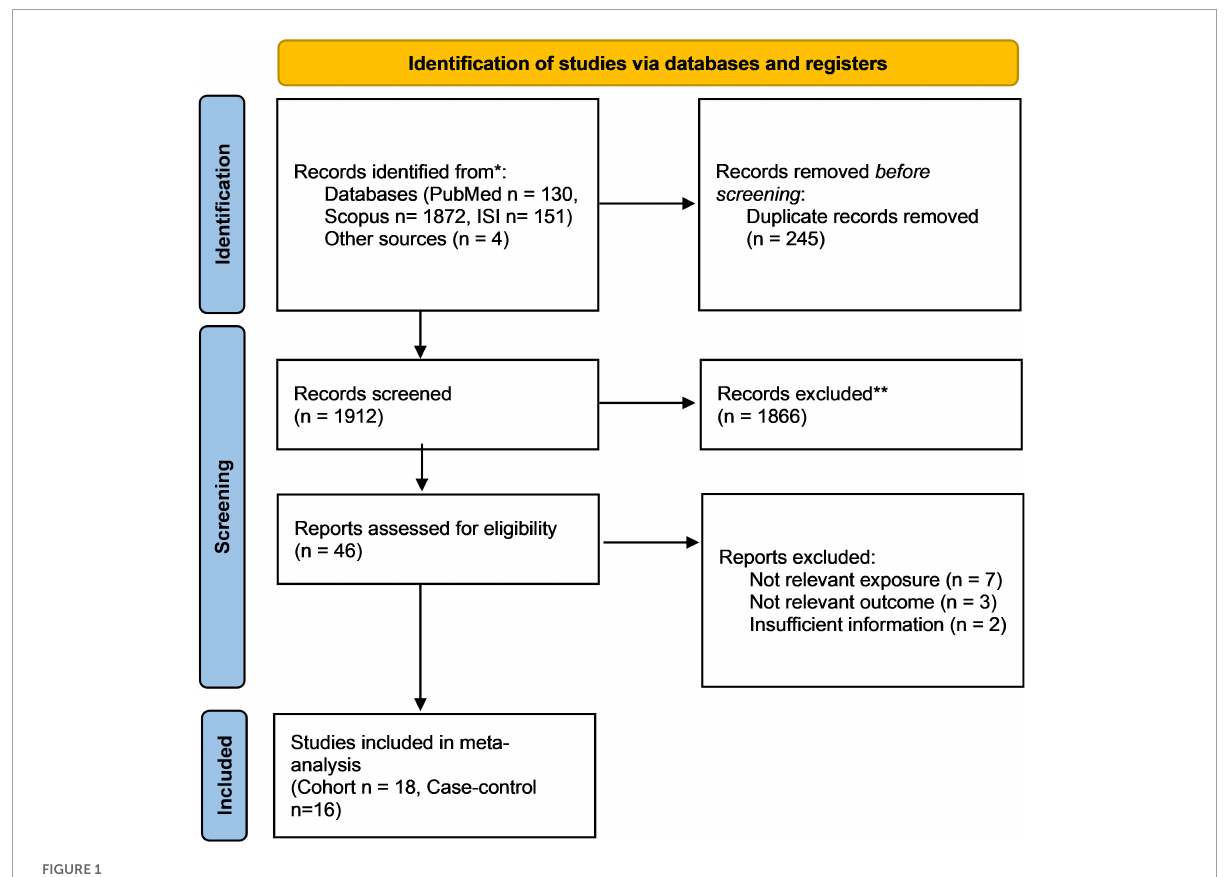
FIGURE1 Flowchart of study